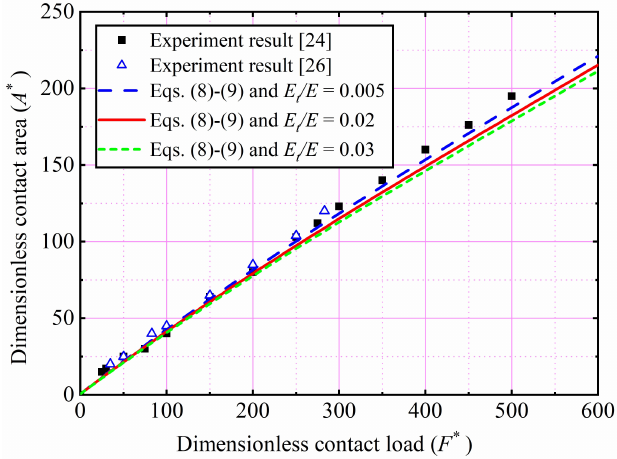
Figure 9. Comparisons of A * as the function of F * predicted by the present model and experiment results at k e = 1 and E t / E ≤ 0.03.